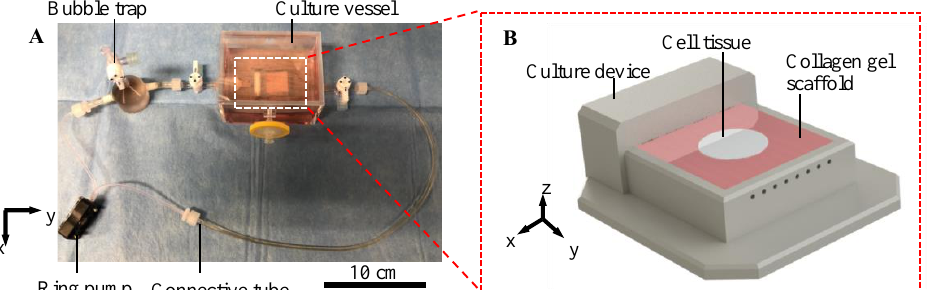
Figure 2. Illustration of the culture system. Overview of the whole perfusion system ( A ). Schematic image of culture device with the collagen scaffold ( B ).